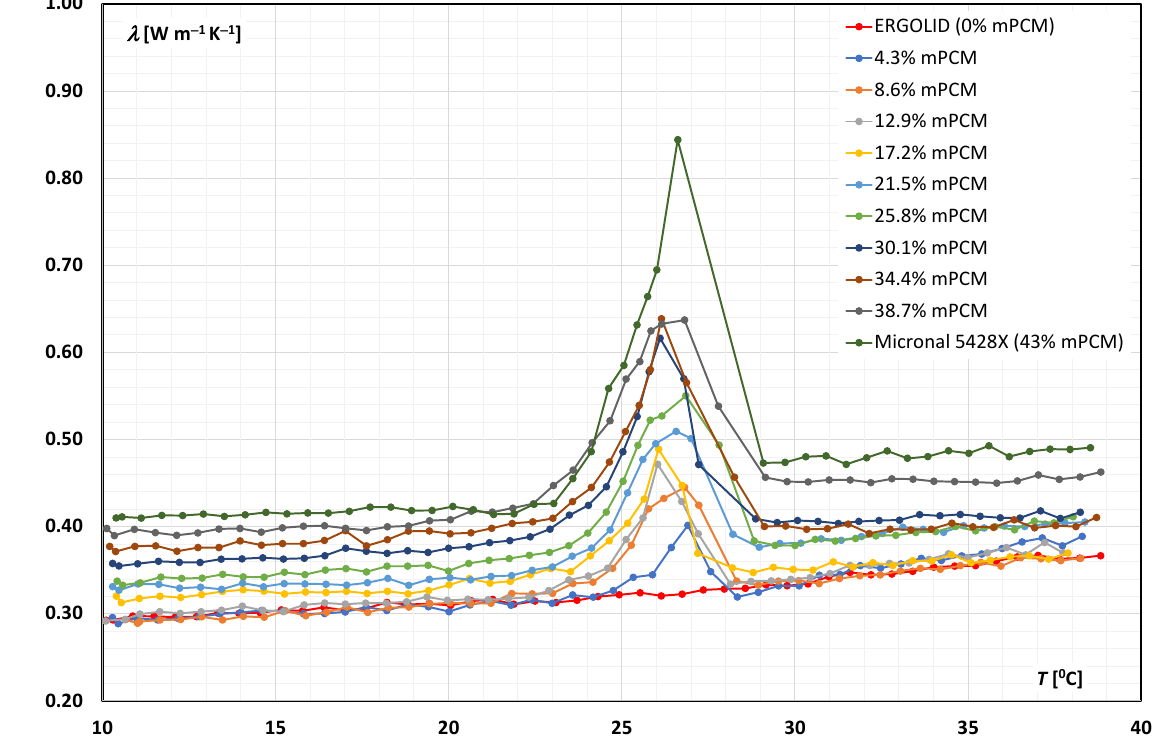
Figure 3. Thermal conductivity of mPCM slurries based on aqueous propylene glycol as a function of temperature.